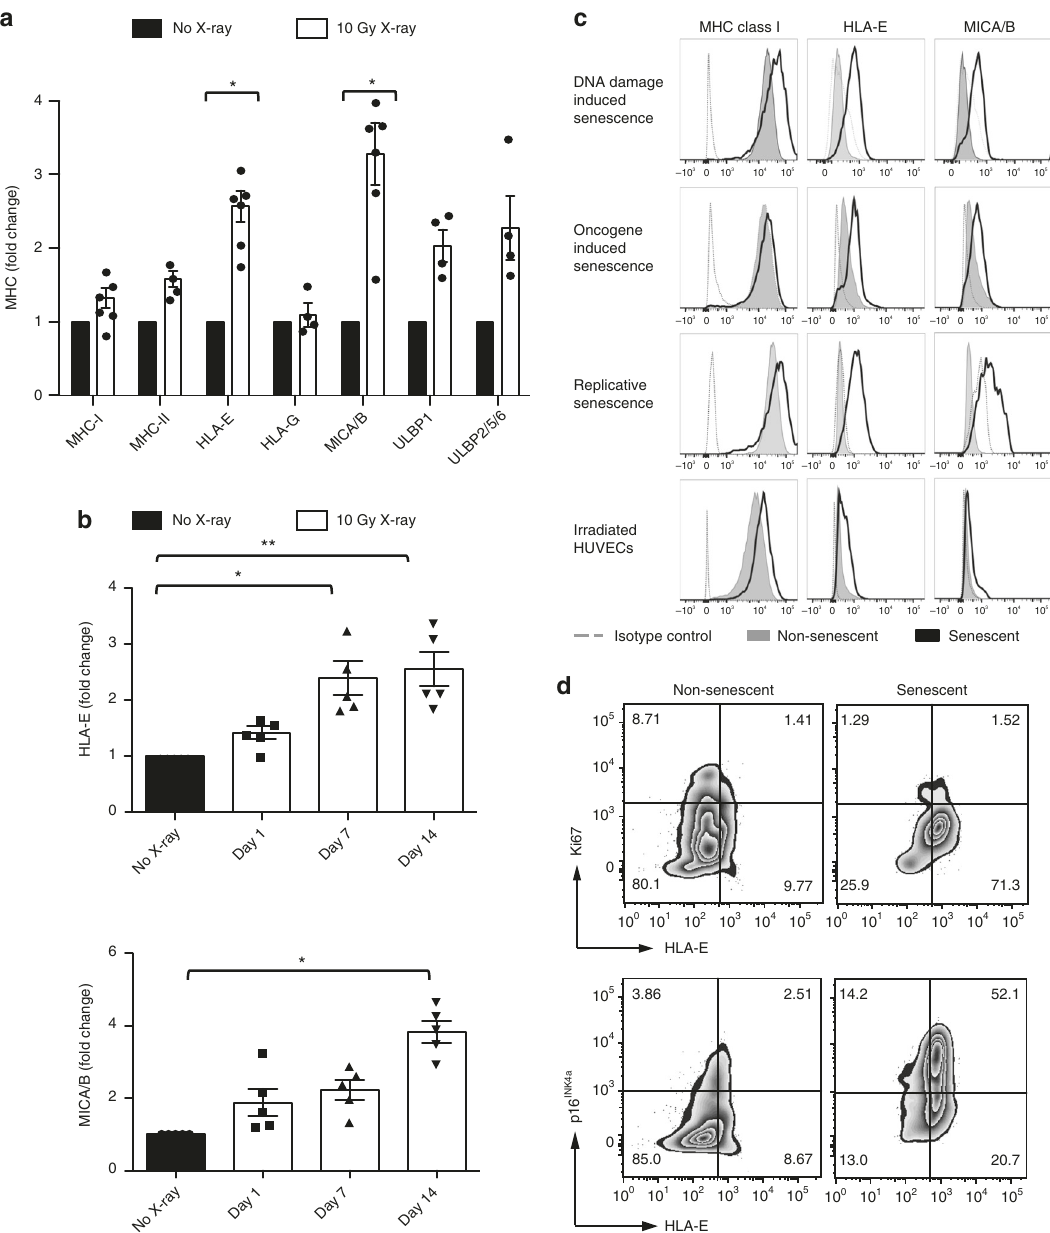
Fig. 1 Senescent human fi broblasts express atypical MHC molecules. a Primary human fi broblasts were derived from the human skin and induced to senesce by ionising radiation (IR, 10 Gy X-ray). MHC expression by senescent fi broblasts (white bars) analysed at day 14 after IR using fl ow cytometry ( n = 6 different donors for MHC-I, HLA-E and MICA/B, n = 4 for MHC-II, HLA-G and ULBP). Mean fl uorescence intensity (MFI) values are shown as fold change compared with non-irradiated controls, set as one (black bars). b Time course of HLA-E and MICA/B expression at the indicated intervals after irradiation ( n = 5). c Representative FACS plots of the total MHC-I, HLA-E and MICA/B expression in senescent fi broblasts induced by ionising radiation (DNA-damage induced senescence), H-RAS activation (oncogene-induced senescence) or continuous passaging (replicative senescence). MHC expression was compared between senescent (black lines), non-senescent ( fi lled histograms) and isotype controls (dashed lines). Human umbilical vein endothelial cells (HUVECs) were irradiated (10 Gy), and MHC expression analysed by fl ow cytometry as previously described. d Flow-cytometry analysis of co-expression of HLA-E and Ki67 and p16 INK4a on irradiated fi broblasts (day 14 after irradiation) and non-irradiated controls. Numbers indicate percentages of cells per quadrant. The data are representative of at least three independent experiments from distinct samples. Statistical signi fi cance calculated with Mann – Whitney U test ( a ) and repeated measures ANOVA with Bonferroni correction ( b ). The data presented as means± standard error of the mean (SEM). * p < 0.05, ** p < 0.01, *** p < 0.001, **** p <